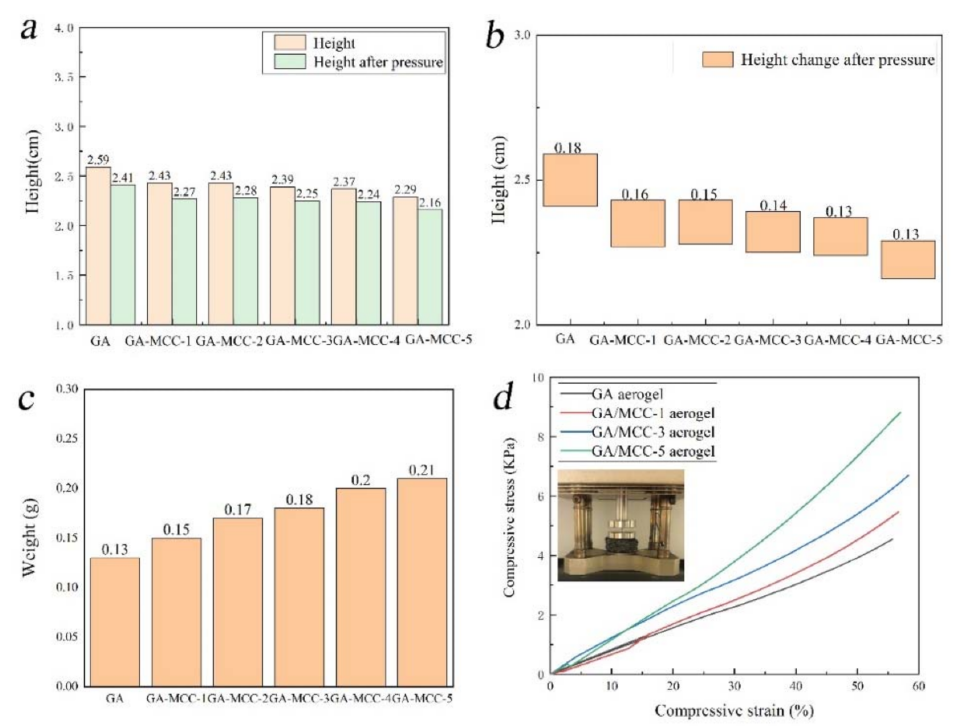
Figure 7. ( a ) Height diagram, ( b ) height change diagram after pressure, ( c ) weight diagram, and ( d ) stress–strain curve of GA aerogel and GA-MCC (1–5)